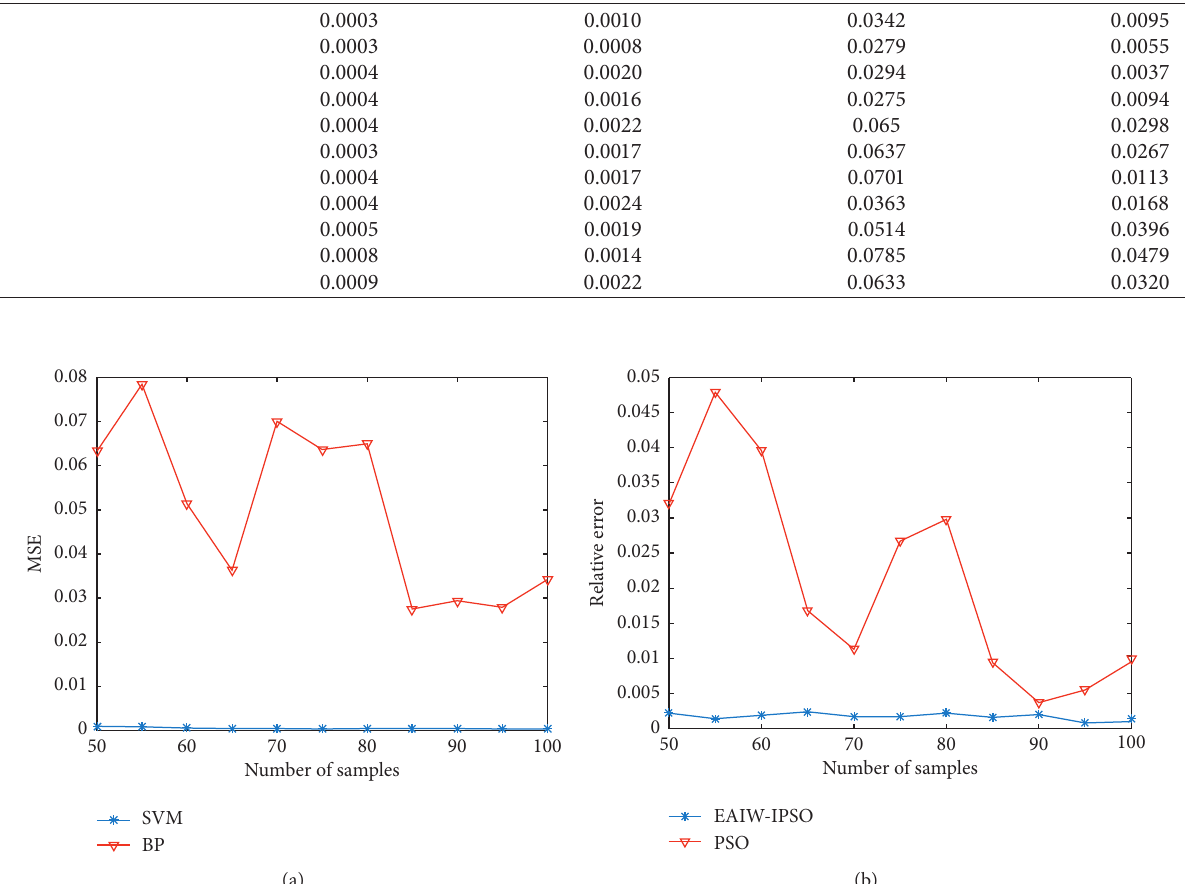
Figure 2: Experimental results for the second case under different sample sizes: (a) the sample size and MSE; (b) the sample size and the corresponding relative error of the optimal objective function